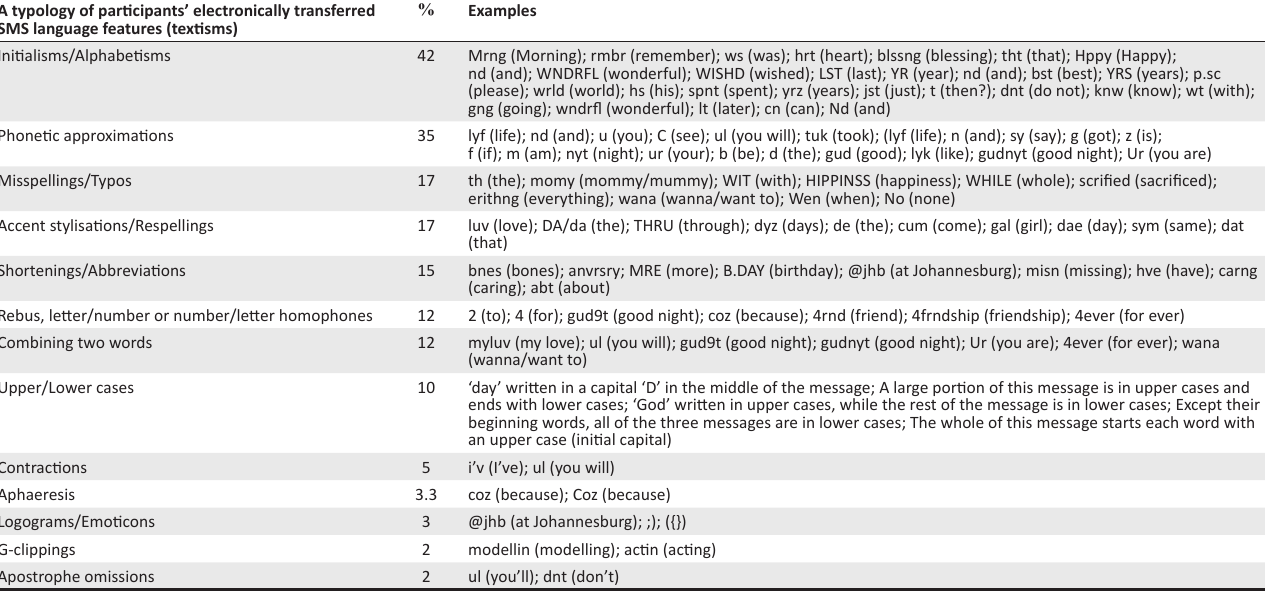
TABLE 2: Participants’ electronically transmitted SMS language features and corresponding full versions. A typology of participants’ electronically transferred SMS language features (textisms)